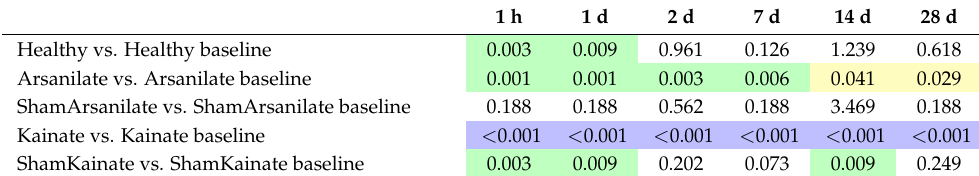
Table A2. Bonferroni-corrected p values for fraction of the time spent immobile (one-sided Wilcoxon test; p values lower than 0.05, 0.01 and 0.001 are highlighted in yellow, green and blue, respectively). 1 h